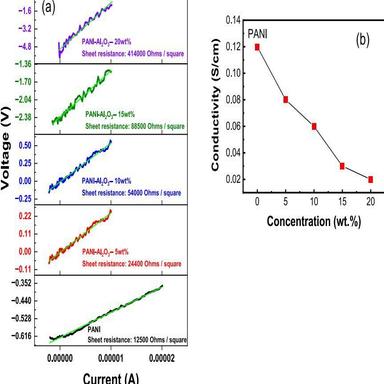
a) I–V curves and b) the conductivity of the of PANI and PANI-Al2O3 nanocomposite films.